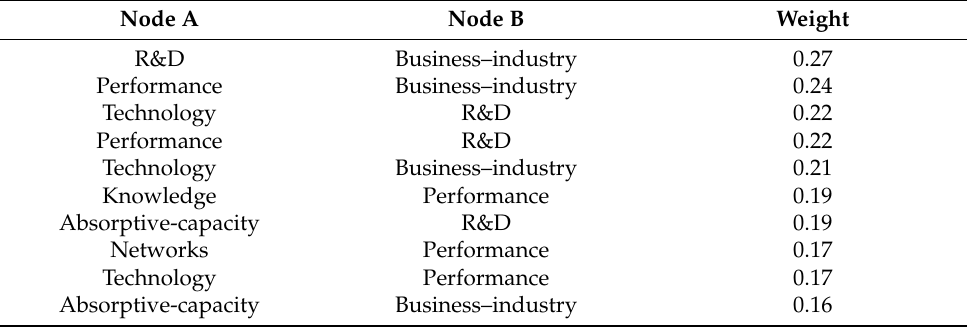
Figure 7. Evolution of the themes period 2017–2020 and thematic network of the cluster R&D. Source: Prepared by the authors on the basis of SciMAT data. Table 7. Thematic network R&D, 2017–2020. Ten relationships with more weight.